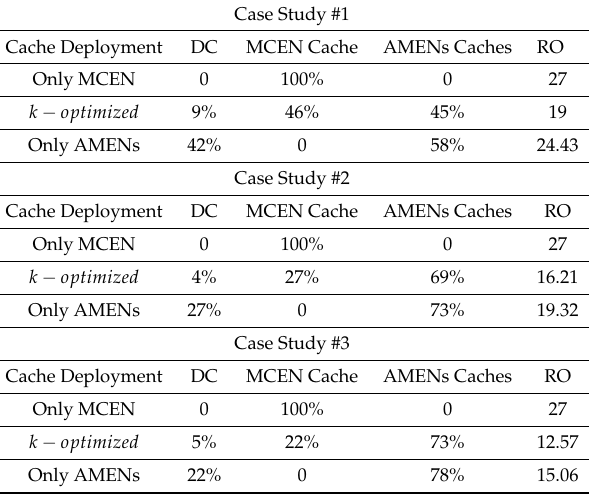
Table 4. Percentage of requests served from the video server, the metro-core edge node (MCEN) cache and the AMEN caches, and the average resource occupation (RO) for each cache deployment in the three case